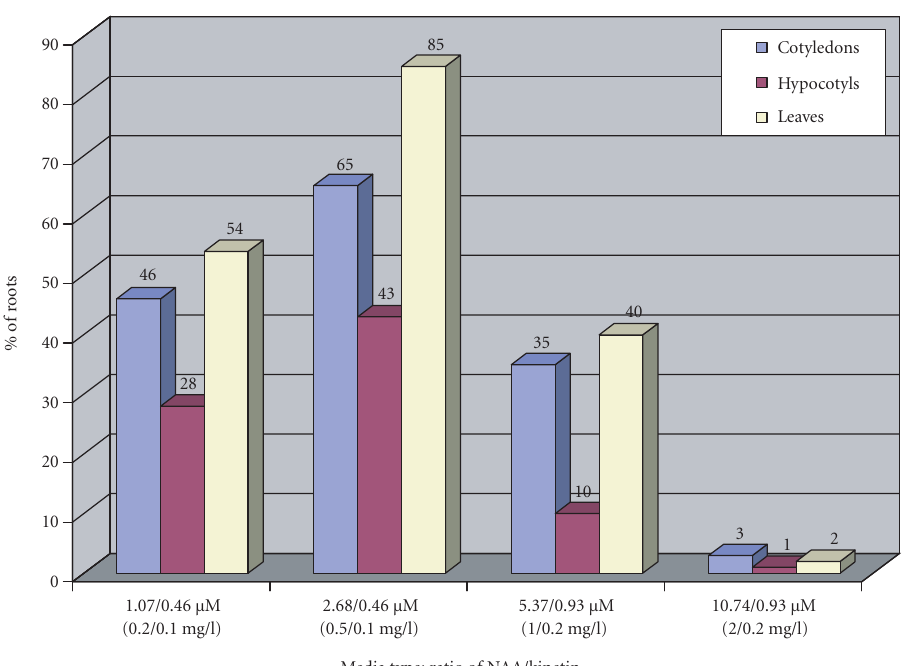
Figure 4: Percentages of roots obtained from callus of Papaver somniferum album as a function of plant growth regulator combinations, after four months of